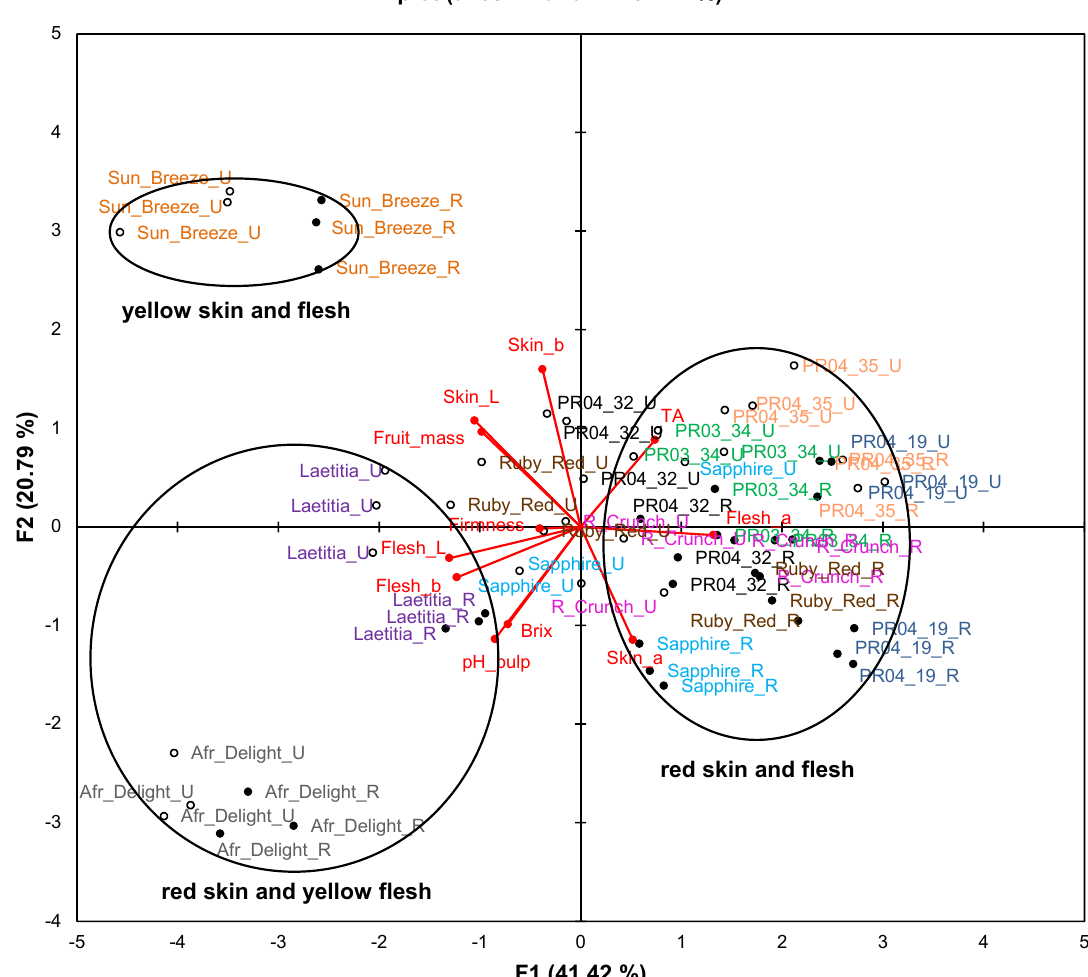
Figure 1. Principal component biplot of fruit attributes of unripe and ripe fruits from